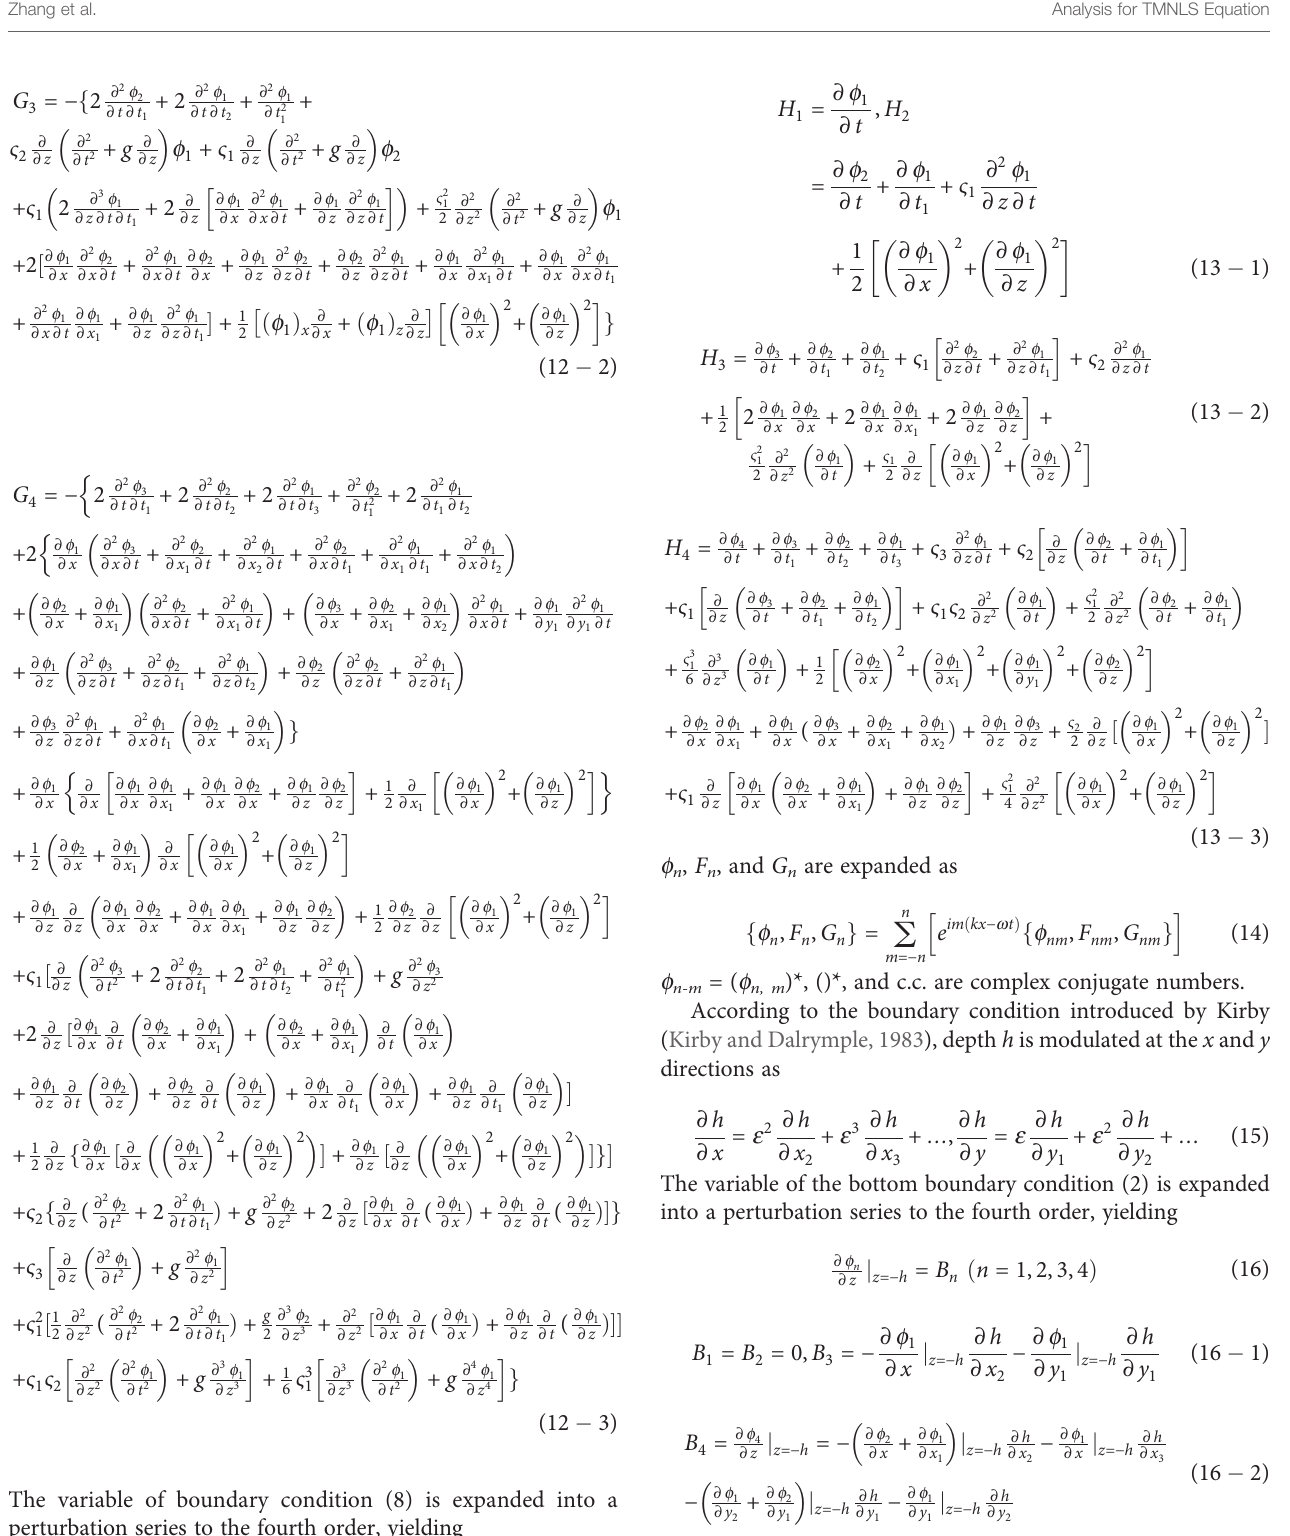
Equations (11), (12), (13), (14), and the bottom boundary condition (16) constitute de fi nition